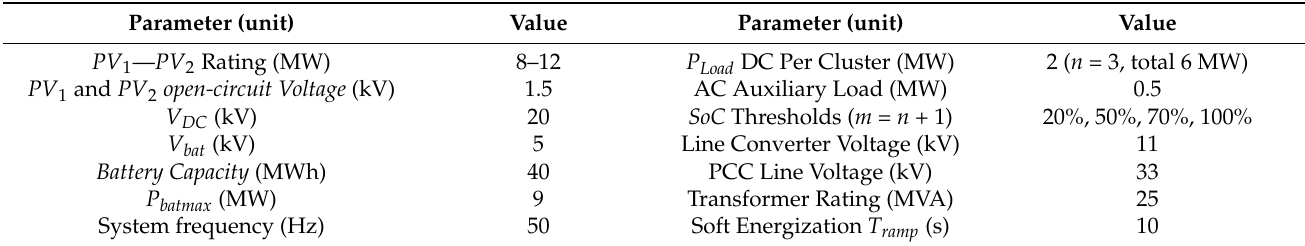
Table 2. Simulated System